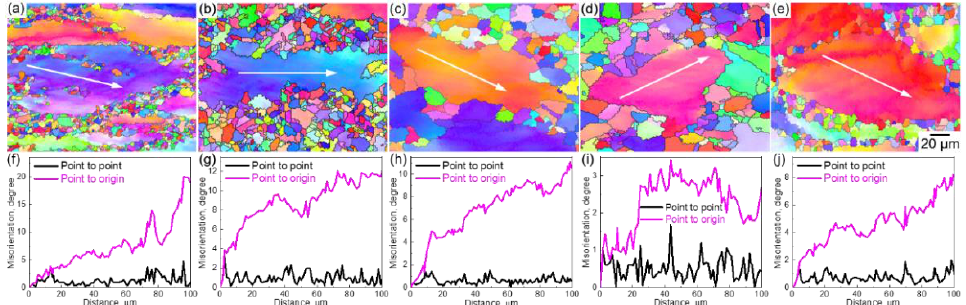
Figure 6. ( a – e ) EBSD IPF maps of the Co 35 Cr 25 Mn 15 Ni 15 Fe 10 TRIP-HEA hot-compressed at ( a ) 1123 K, ( b ) 1173 K, ( c ) 1223 K, ( d ) 1273 K with a strain rate of 0.001 s −1 and at ( e ) 1273 K with a strain rate of 0.1 s −1 . ( f – j ) The corresponding point to point and point to origin misorientation profiles along the arrowheads inserted in the coarse grains.